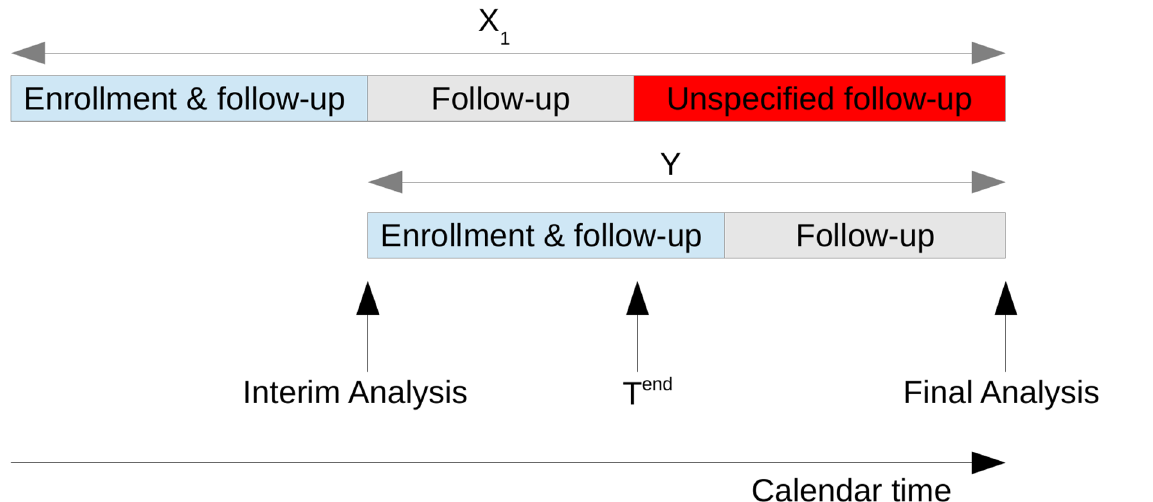
Fig 2. Schematic of a two-stage adaptive trial design with delayed response using patient-wise